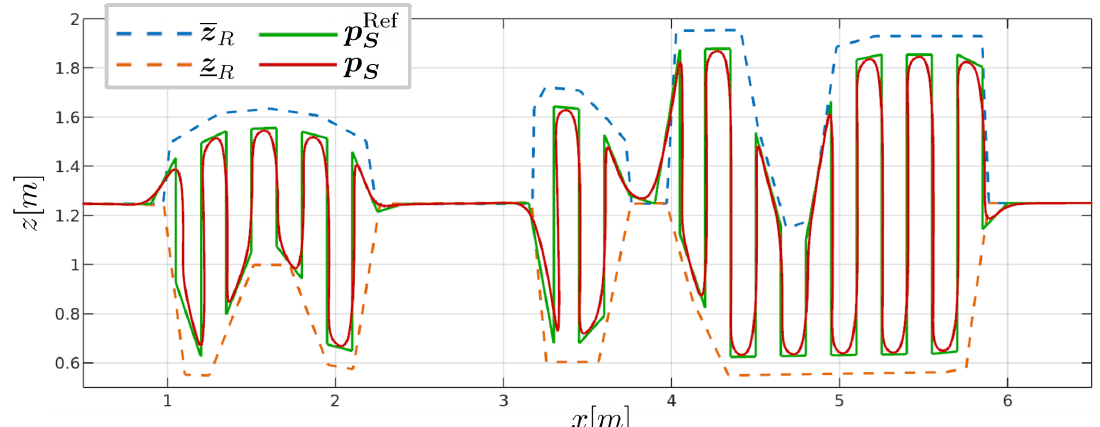
represents a reference lawnmower trajectory S during the experiment is represented by a S